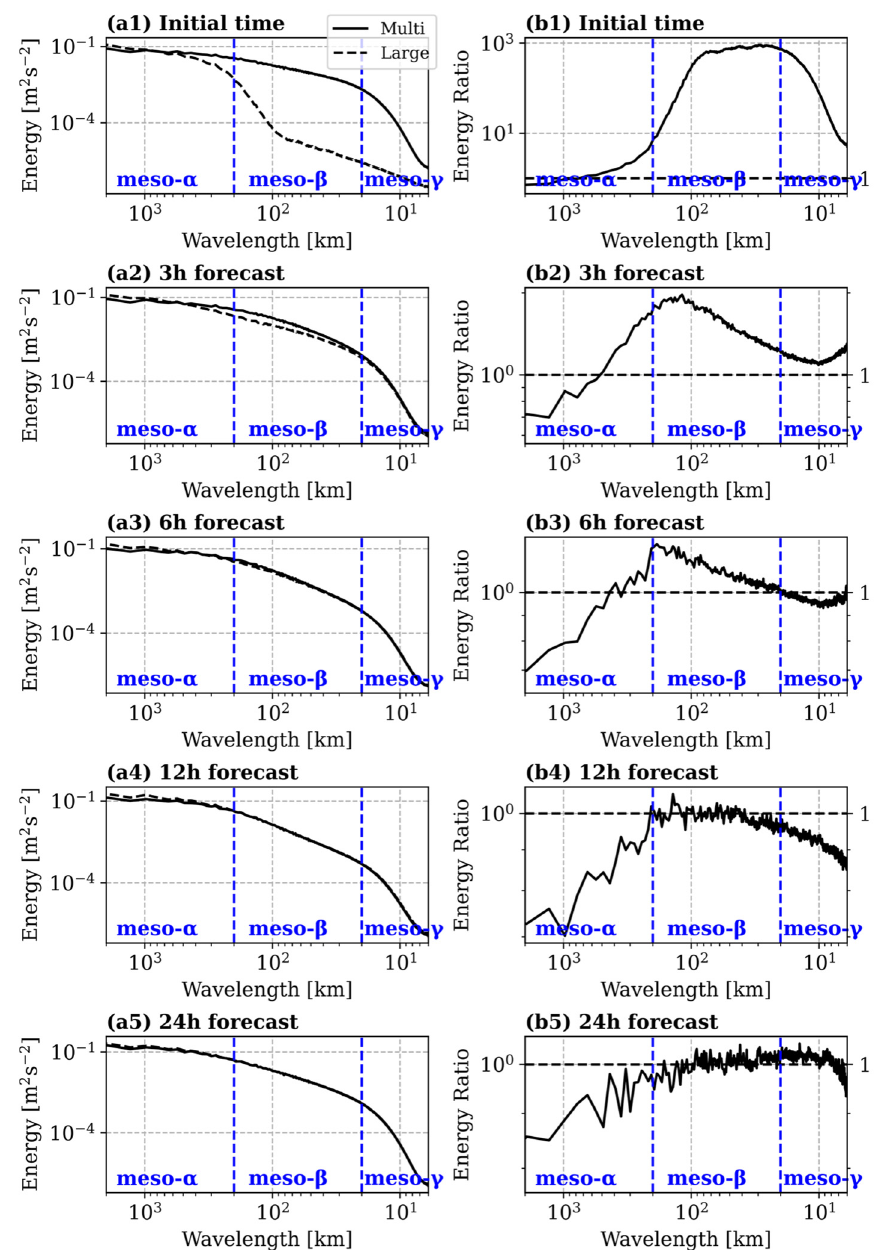
Figure 5. ( a1 – a5 ) Perturbation-energy spectra of MULTI (solid) and LARGE (dashed) and ( b1 – b5 ) the ratio of perturbation-energy spectra between MULTI and LARGE for an 850 hPa zonal wind averaged over 25 forecast cases at analysis times for 3h, 6h, 12h, and 24h forecasts, respectively. The full wavelength range was divided into meso-alpha, meso-beta, and meso-gamma scales as marked by blue dashed lines and texts near the bottom of each subfigure.